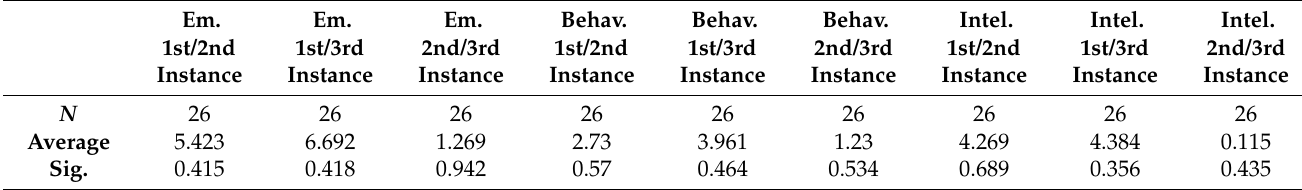
Table 3. Examination for normal distribution of